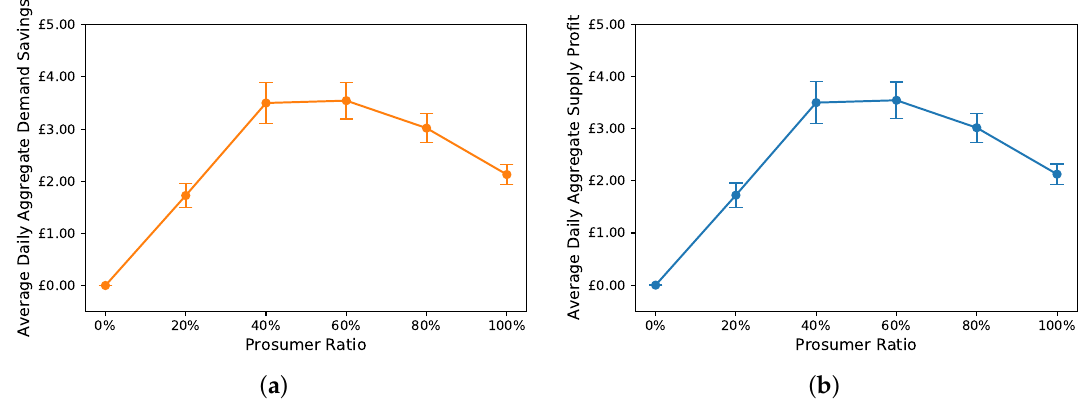
Figure 6. Average daily SP K and DS K for the setting with perfect predictions without storage. Both results are the same in this setting because P T is always in the middle of G b and G s as all agents are inflexible. The error bars represent 95% confidence intervals. ( a ) Average daily DS K . ( b ) Average daily SP K .